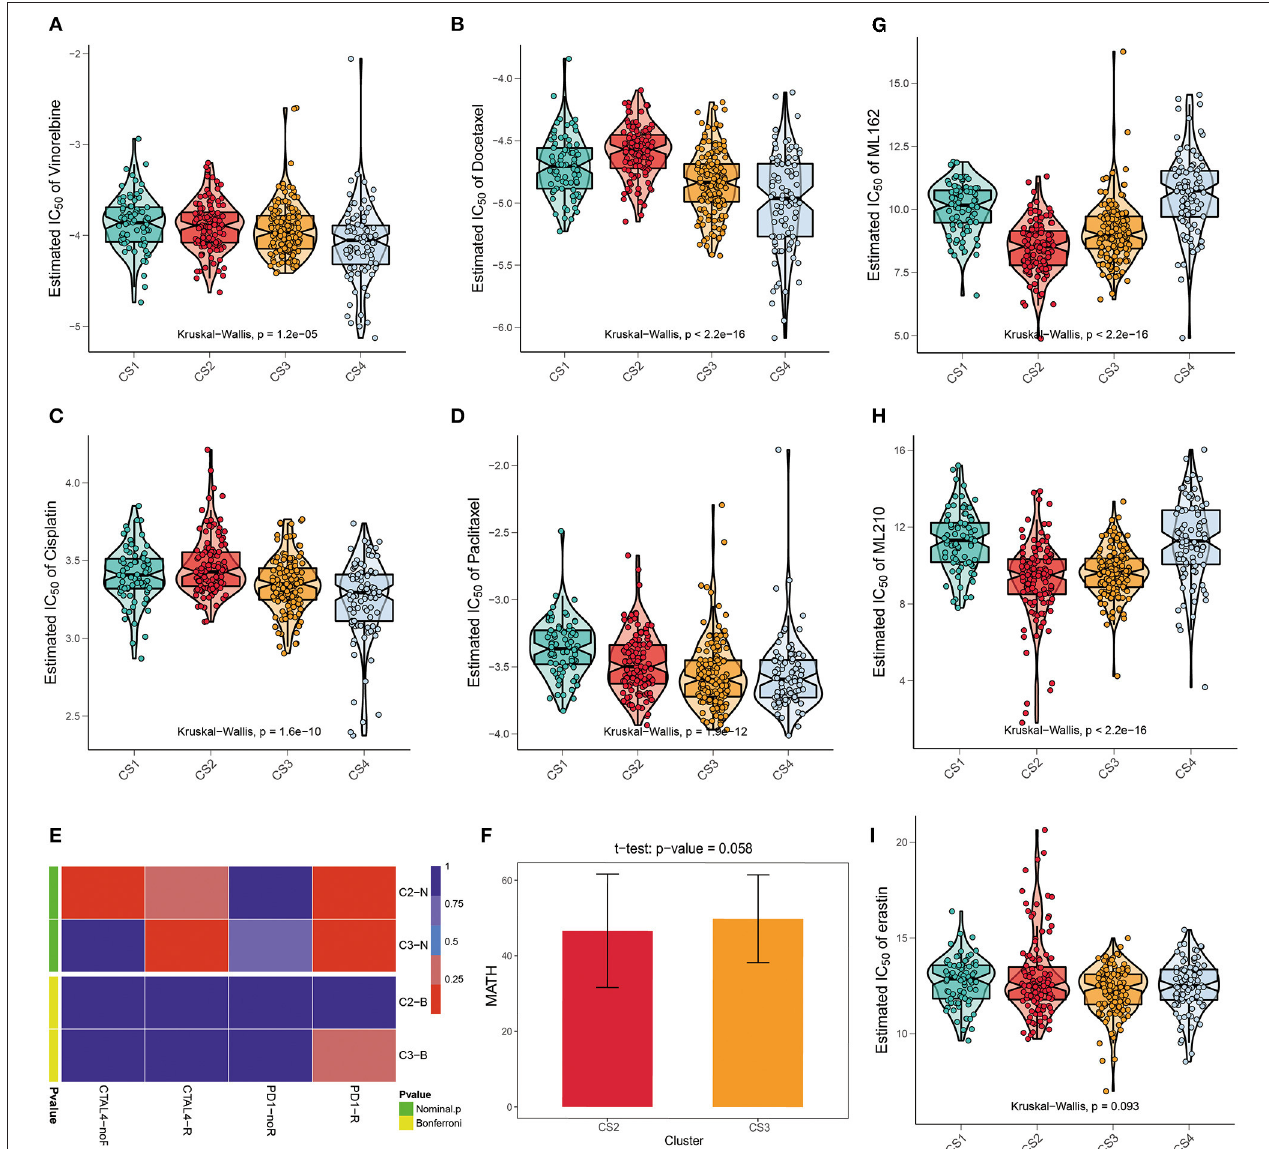
FIGURE 5 | (A–D) The box plots of the estimated IC 50 for common chemotherapy drugs (cisplatin, paclitaxel, docetaxel, and vinorelbine) of lung adenocarcinoma between the four subtypes. (E) Submap analysis manifested that patients in CS3 were more likely to respond to anti-PD1-R immunotherapy. (F) The t test of the MATH value revealed a difference in intra-tumoral heterogeneity between CS2 and CS3. (G–I) The box plots of the estimated IC 50 for three ferroptosis inhibitors, ML162, ML210, and erastin among the four